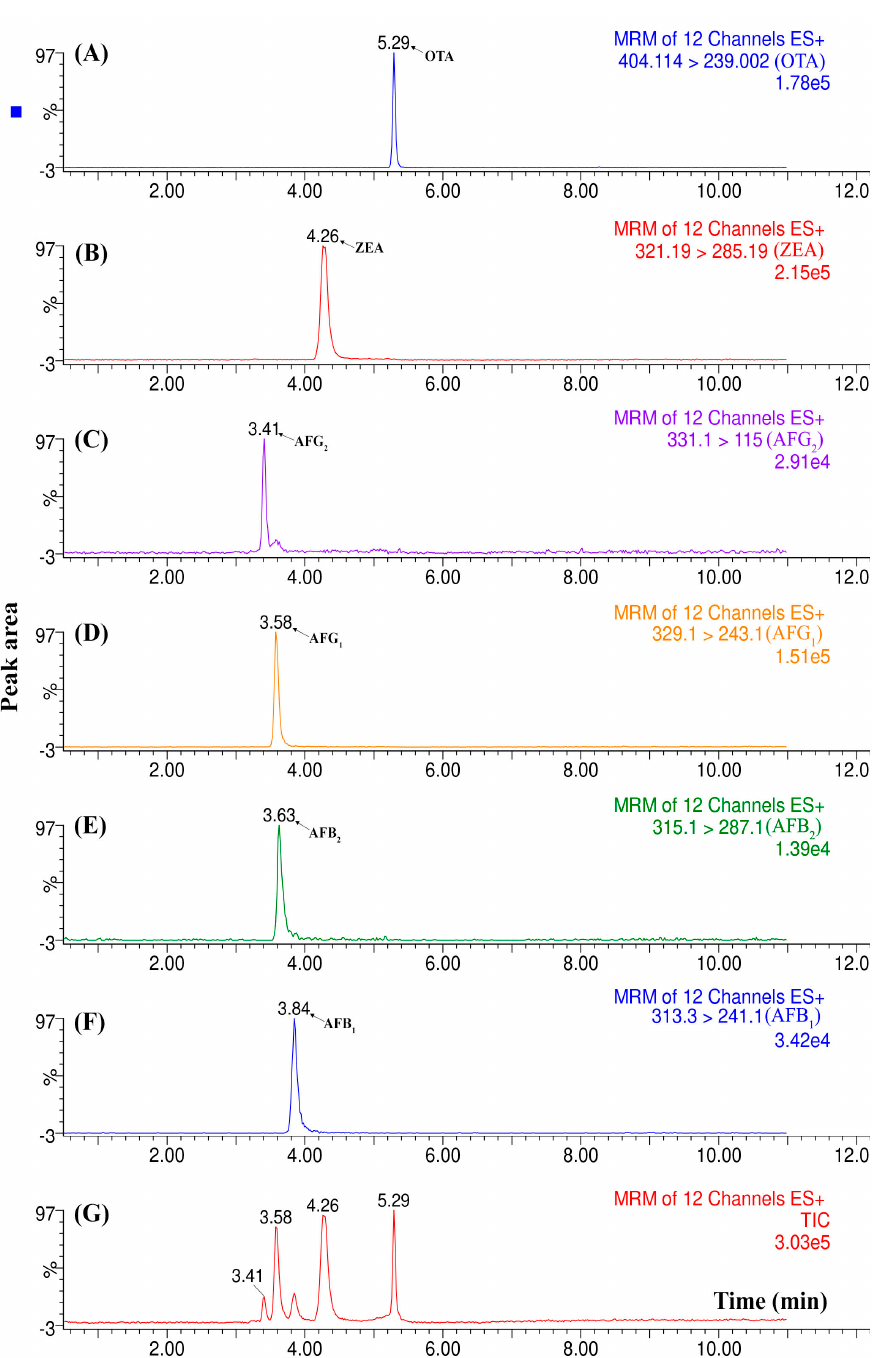
Figure 5. Total ion chromatogram (TIC) and selected reaction monitoring (SRM) of each mycotoxin analyzed in a spiked almond liquor sample. ( A ) OTA ion transition; ( B ) ZEA ion transition; ( C , D ) AFG 1 and AFG 2 ion transitions (Aflatoxin G 1 , Aflatoxin G 2 ); ( E , F ) AFB 1 and AFB 2 (Aflatoxin B 1 , Aflatoxin B 2 ) ion transitions; ( G ) TIC of the analyzed sample.